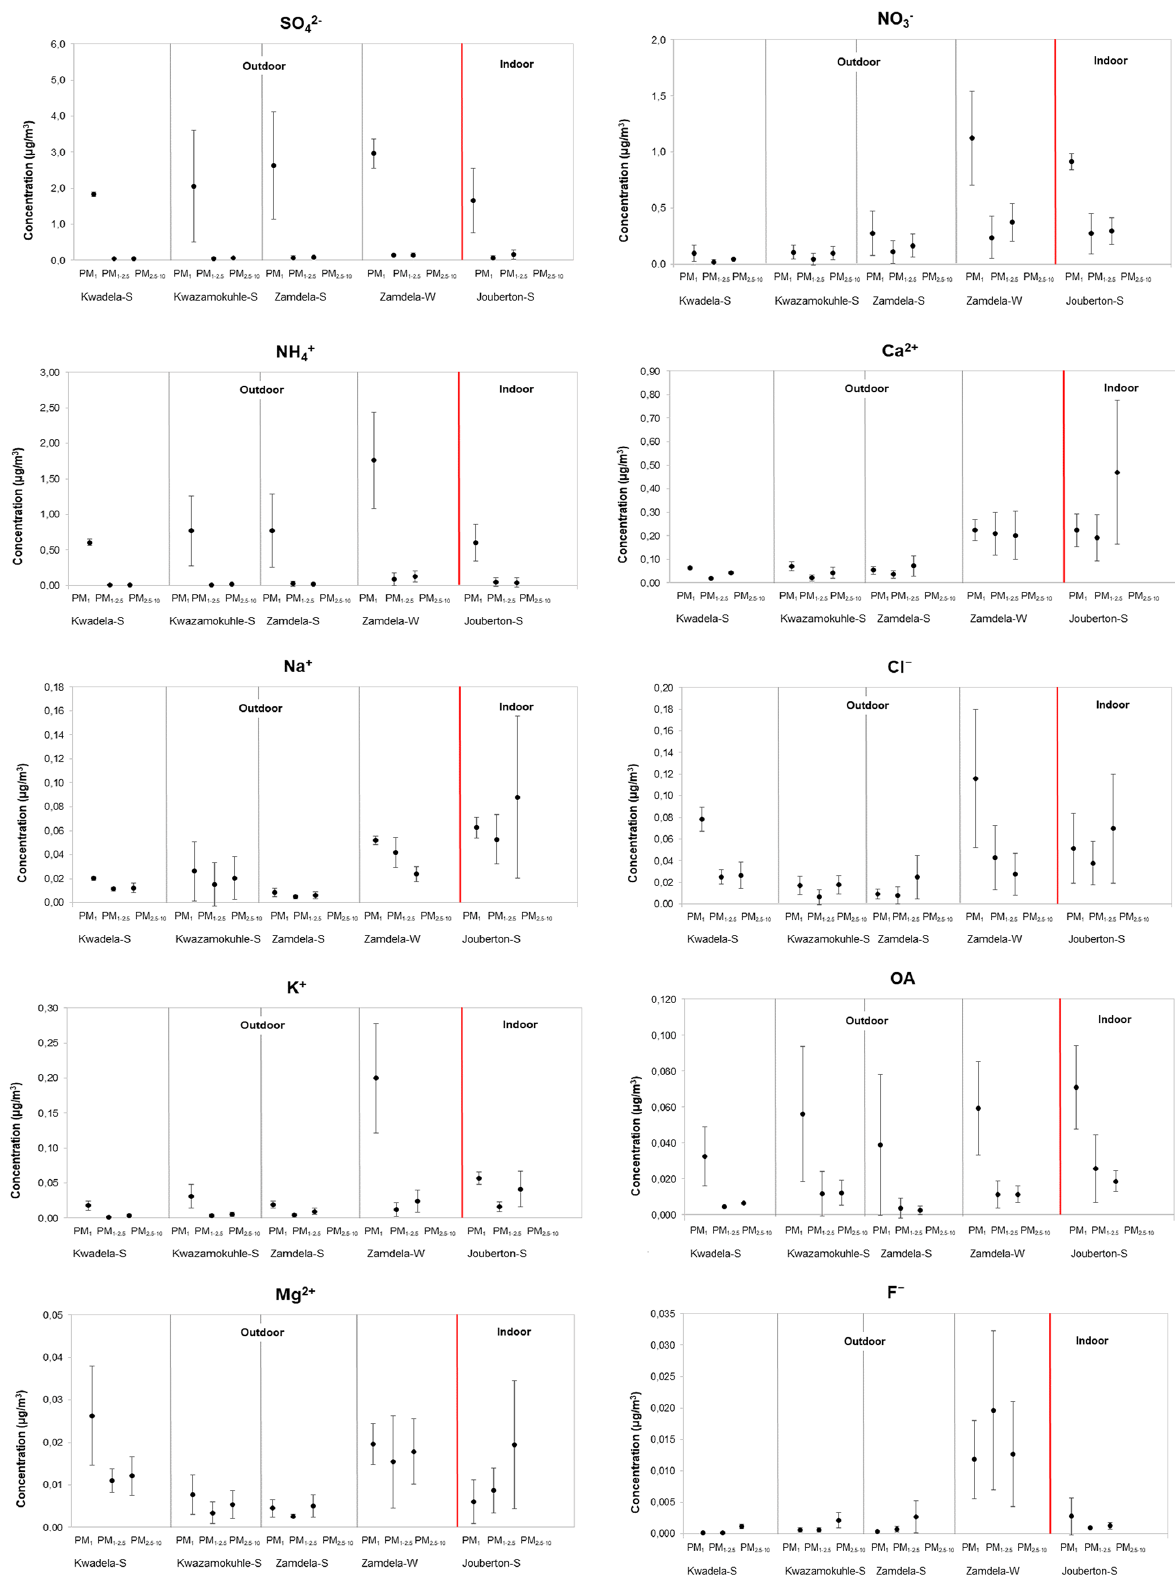
Figure 3. Mean concentrations ( ± SD) of inorganic ionic species and water-soluble OAs measured in PM 1 , PM 1 − 2 . 5 , and PM 2 . 5 − 10 at each site during respective sampling